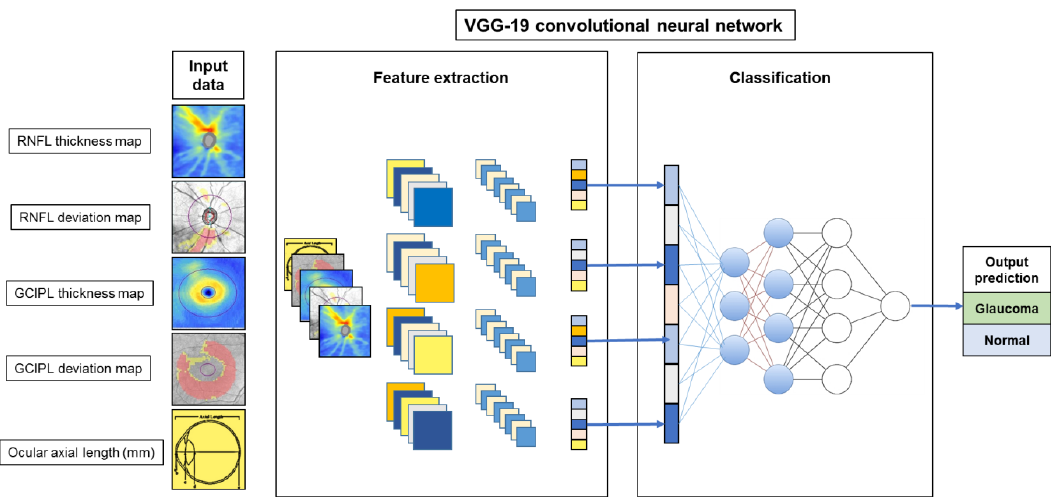
Figure 1. Schematic overview of the proposed deep learning model of convolutional neural network (CNN)-based visual geometry group deep (VGG-19) architecture. The input data were a stack of two-dimensional images (176 × 176 pixel) composed of four optical coherence tomography images (thickness and deviation maps of retinal nerve fiber layer (RNFL) and ganglion cell–inner plexiform layer (GCIPL) analyses) and a matrix image with an ocular axial length value.